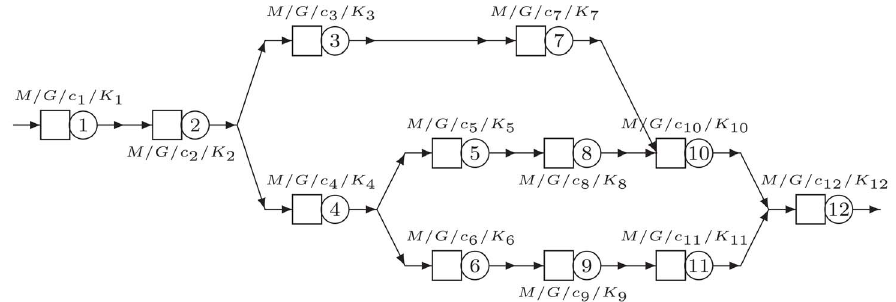
Figure 7. Network structure C2.